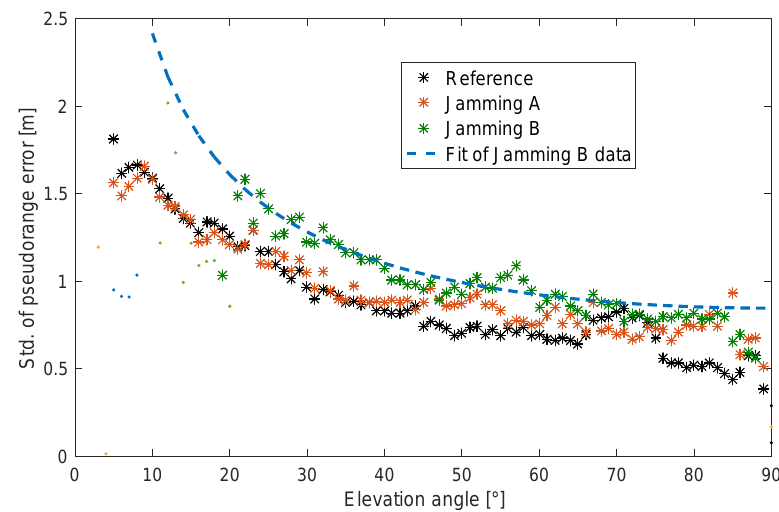
Figure 7. Measured dependency of the pseudorange error statistics (standard deviation) on the elevation angle in the lab experiment.